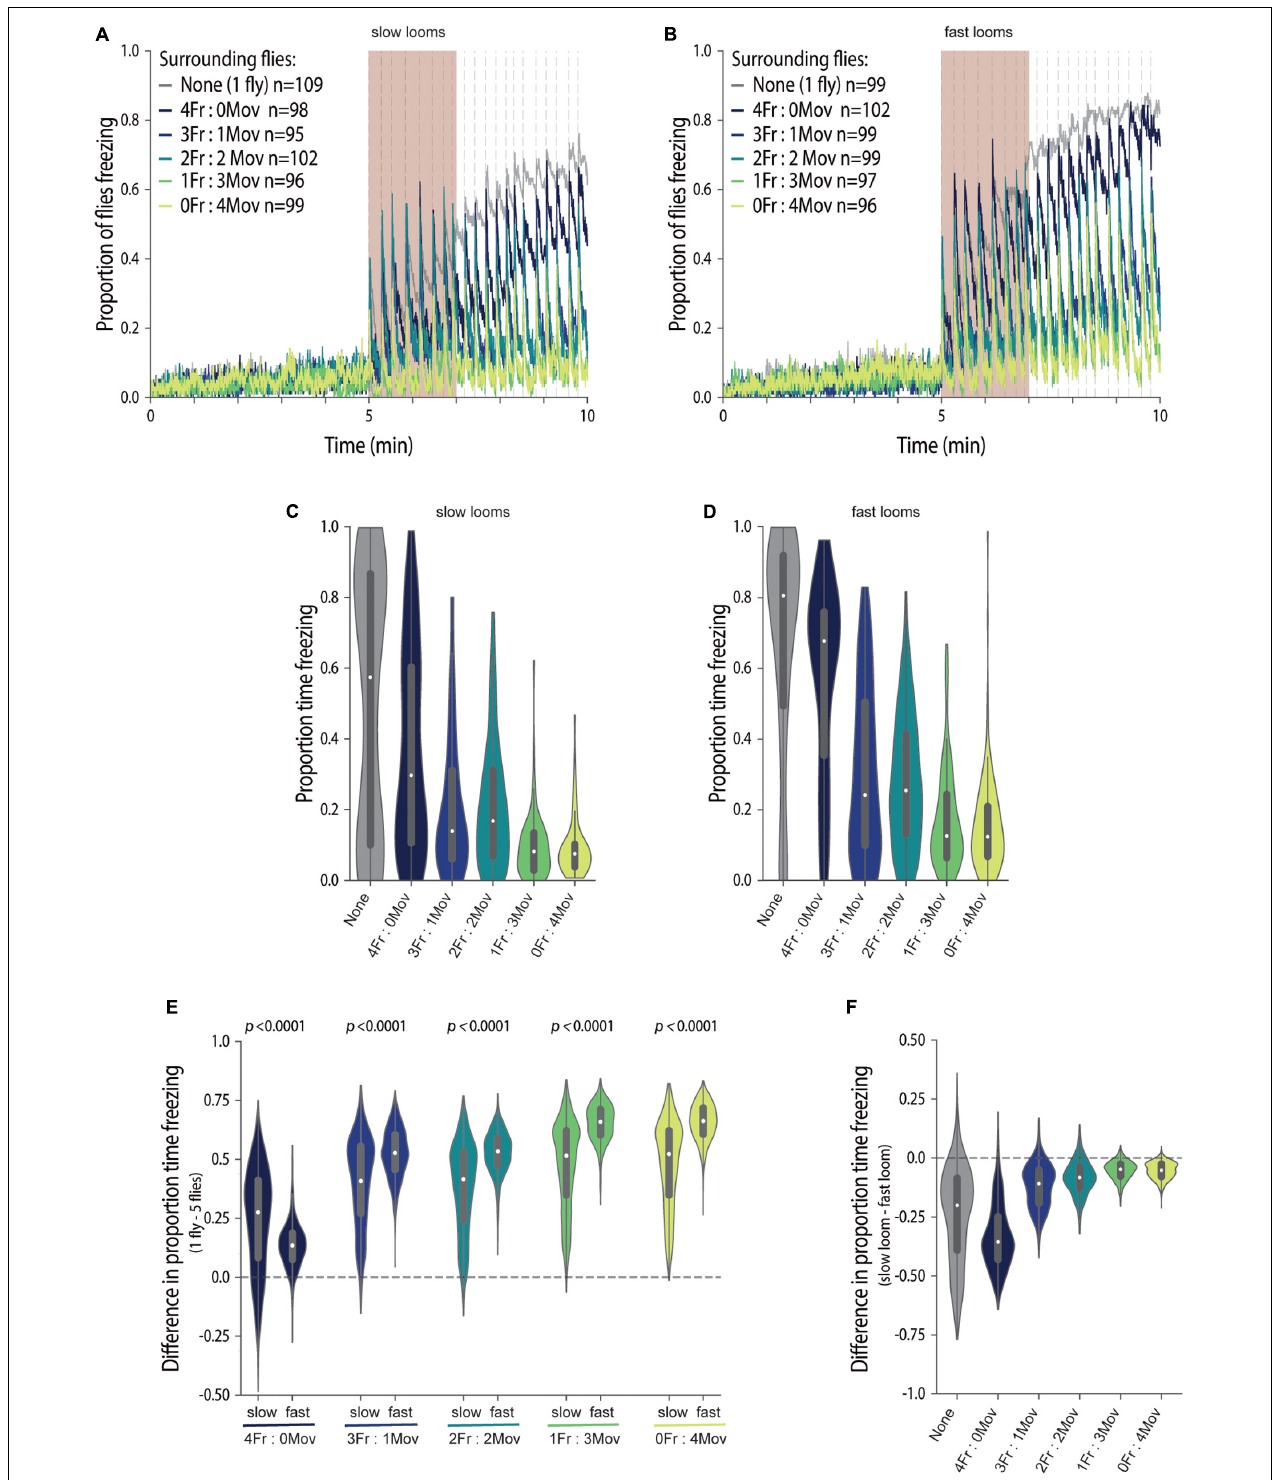
FIGURE 4 | Social environment overrides the perceived imminence of a threat in guiding freezing responses. (A–F) We manipulated focal flies to surround with four flies creating groups with different proportions of flies that always move (blind flies, NorpA) and flies that are optogenetically made to freeze (LC6 > CsChrimson). The colours codes for group composition are presented in (A,B) . Fraction of focal flies freezing throughout the experiment when exposed to slow (A) or fast looming